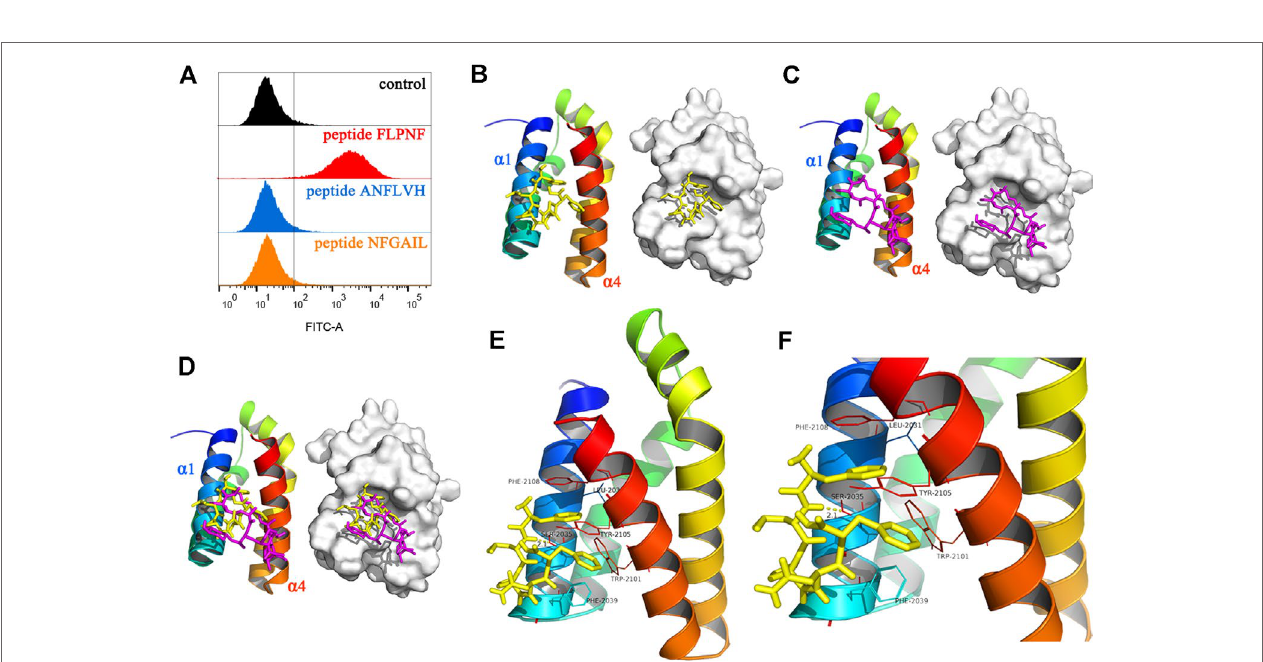
FIGURE 6 | Binding of peptide FLPNF to mTOR and solution structure of the peptide FLPNF-FRB-domain complex. (A) Flow cytometry results revealed the peptide FLPNF binds to mTOR. (B) The ribbon model (left) and the surface view (right) of the mTOR inhibitor peptide FLPNF docked into the binding site on the FRB domain. (C) The localization and conformation of rapamycin bound to the FRB domain in the FKBP12-rapamycin-FRB ternary complex (Choi et al., 1996). In (D) , the Peptide FLPNF bound to the FRB domain adopts a position similar to that for rapamycin. The orientation of the FRB domain was same in (B – D) . (E, F) The predicted computational model of the peptide FLPNF-FRB-domain complex. Peptide FLPNF is shown in a stick model, the protein residues are represented in a ribbon model, and hydrogen-bonds appear as yellow dotted